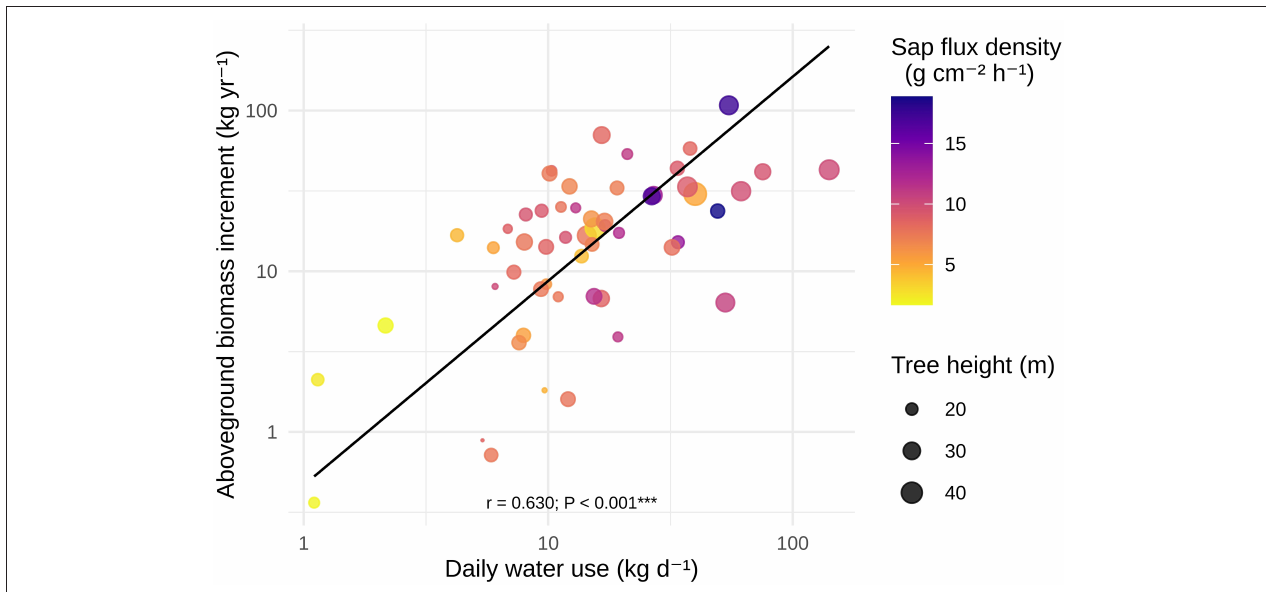
FIGURE 4 | Results of standardized major axis regressions of species-level averages of biomass increment vs. daily water use. Color: average sap flux density; size: average tree